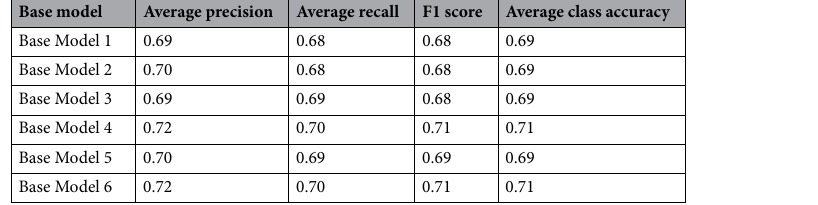
Table 2. Classification metrics for the base